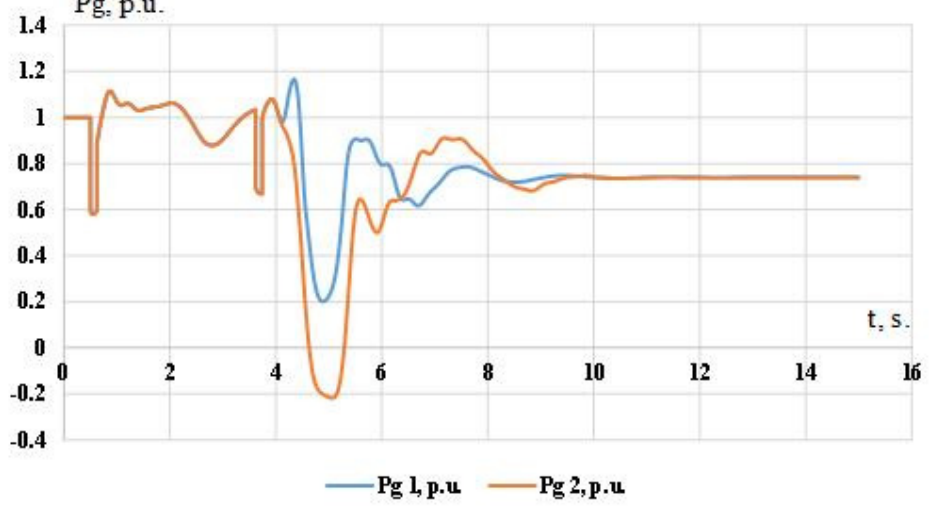
Figure 22. Generator G 2 active Figure 23. Generator G 2 active power.